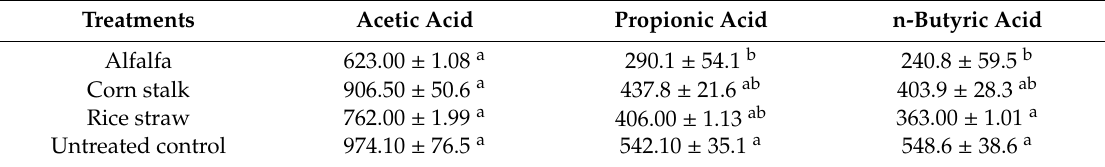
Table 6. Volatile fatty acid peak area.